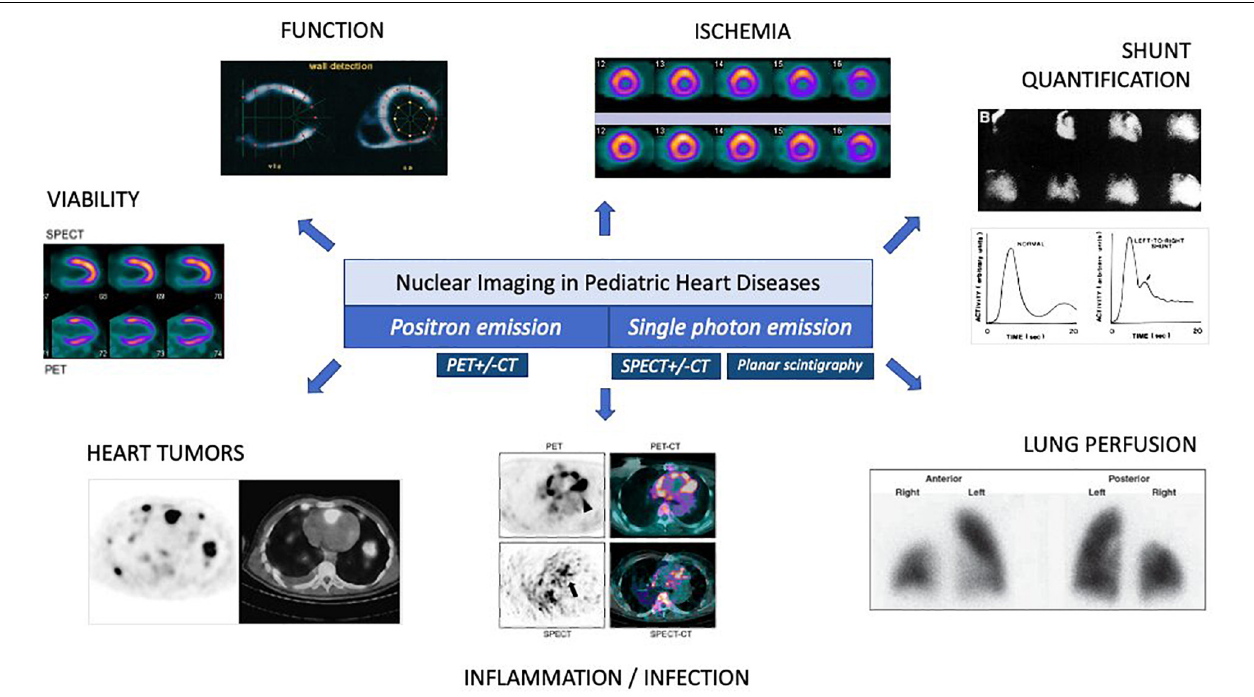
FIGURE 1 | Overview of nuclear imaging in pediatric cardiology. CT, computed tomography; PET, positron emission tomography; SPECT, single-photon emission computed tomography.